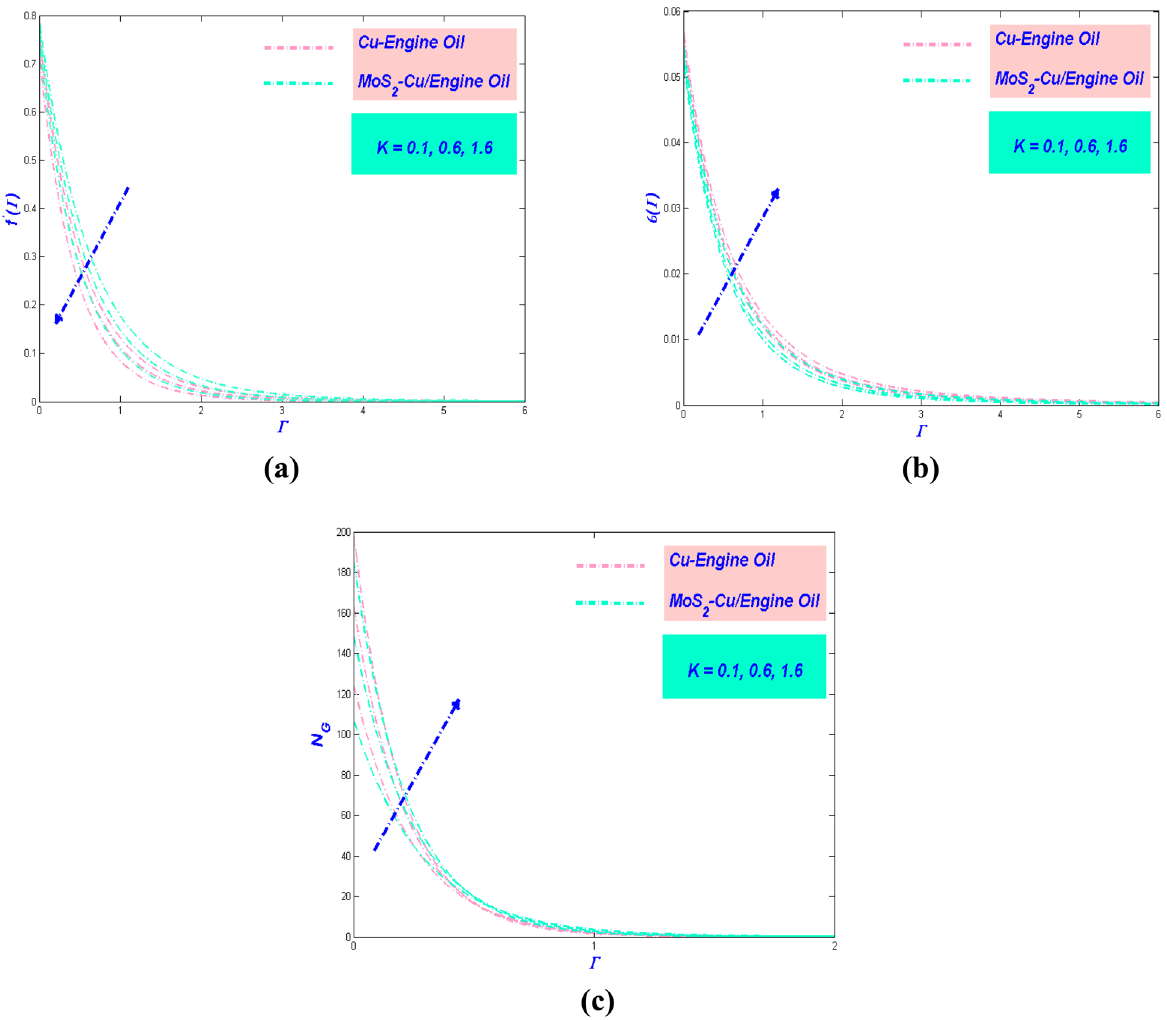
Figure 7. ( a ) Velocity, ( b ) temperature, and ( c ) entropy change with K